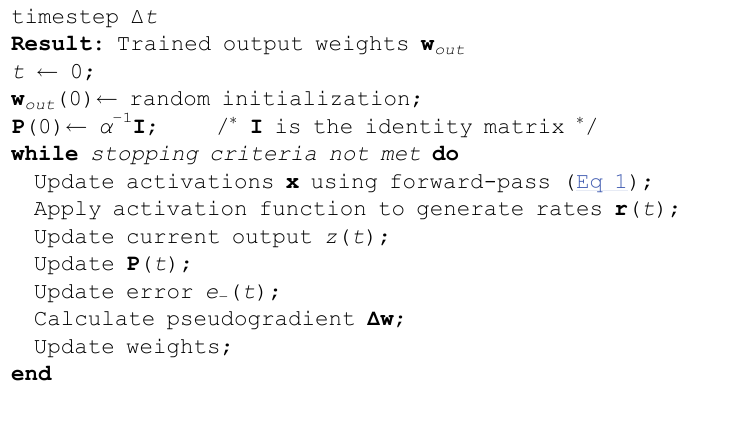
Algorithm 1 : The basic FORCE RLS